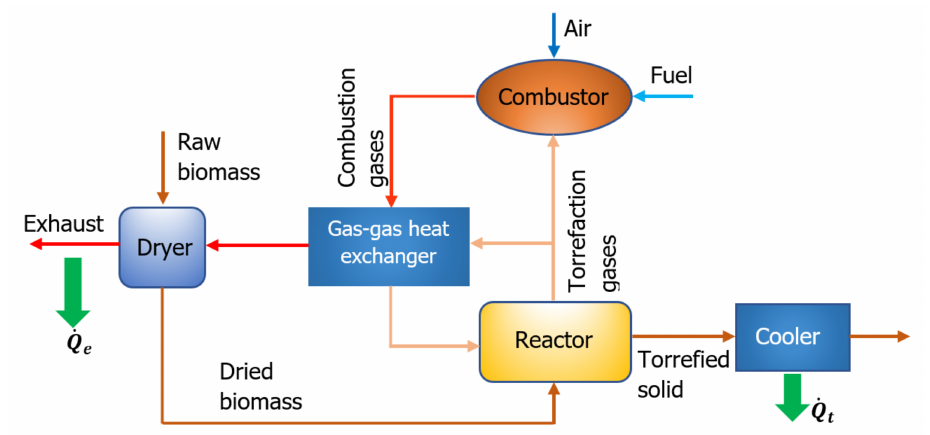
Figure 1. The layout of a biomass torrefaction